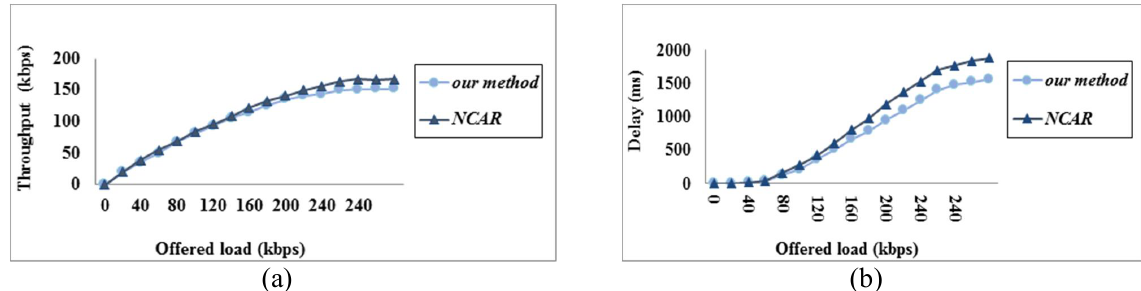
Fig. 5. Results from a random topology with 100 nodes. (a) Average throughput. (b) Average end to end